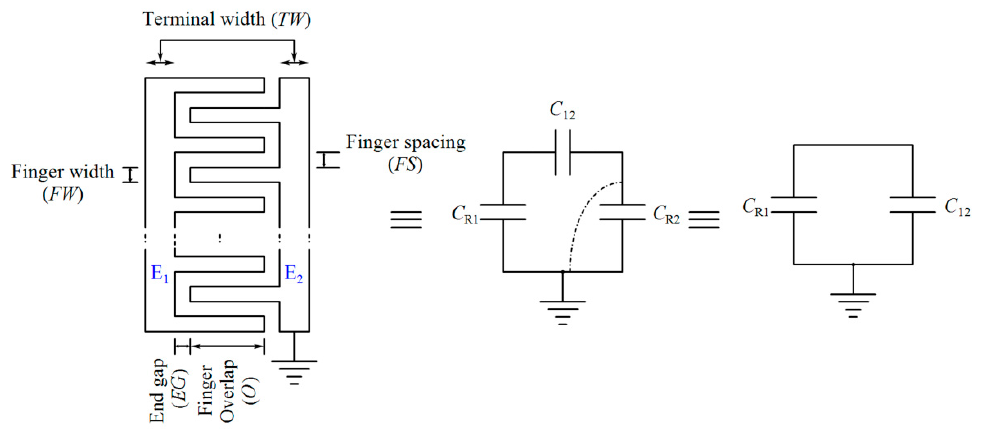
Table 2. Five phases of the sensor and the related situations of the controlling signal.